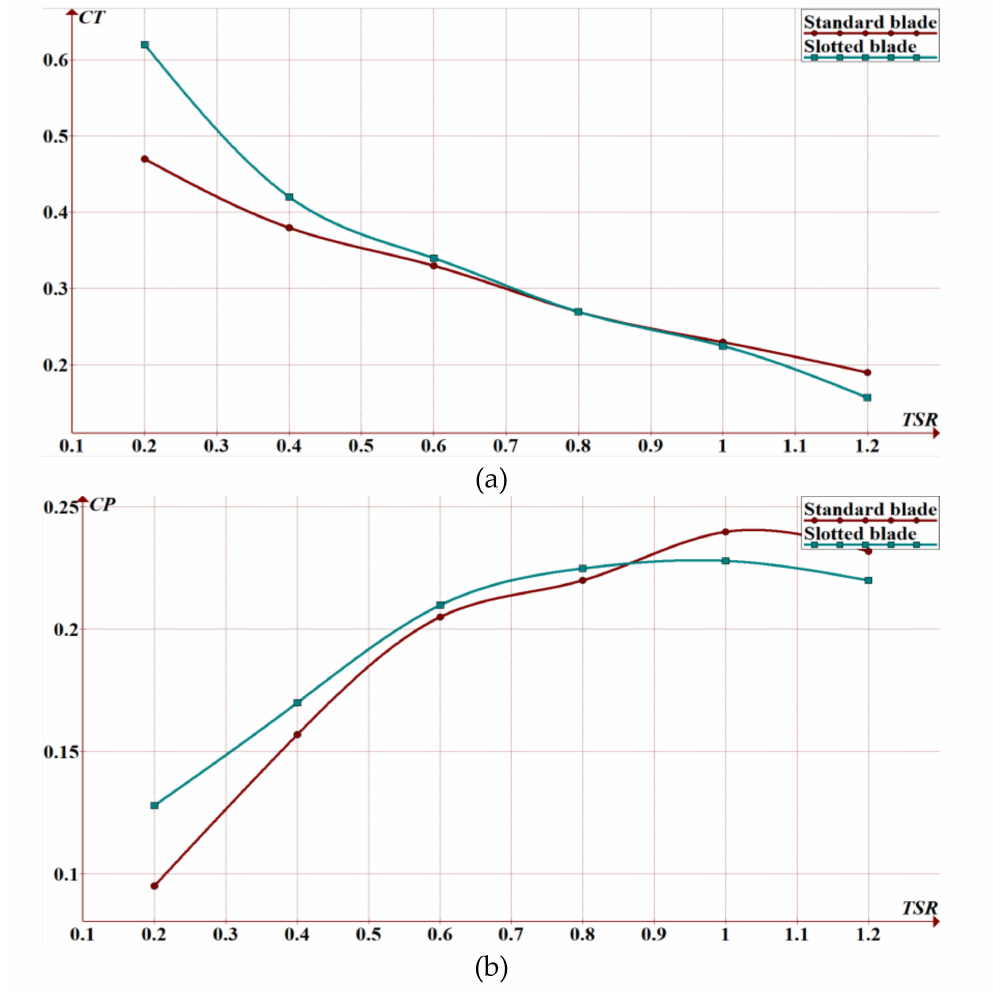
Figure 14. Averaged values obtained in terms of the torque and power coefficients (standard blade β = 0 ◦ , slotted blade β = 25 ◦ ): ( a ) torque coefficient values; ( b ) power coefficient values;